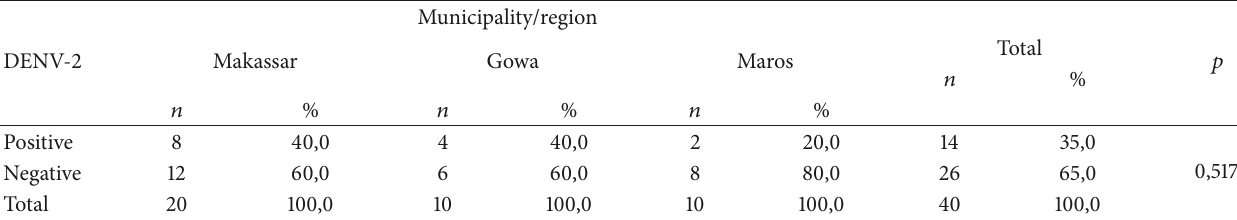
Table 2: Comparison of DENV-2 serotypes in endemic areas of dengue fever in Makassar, Gowa, and Maros.